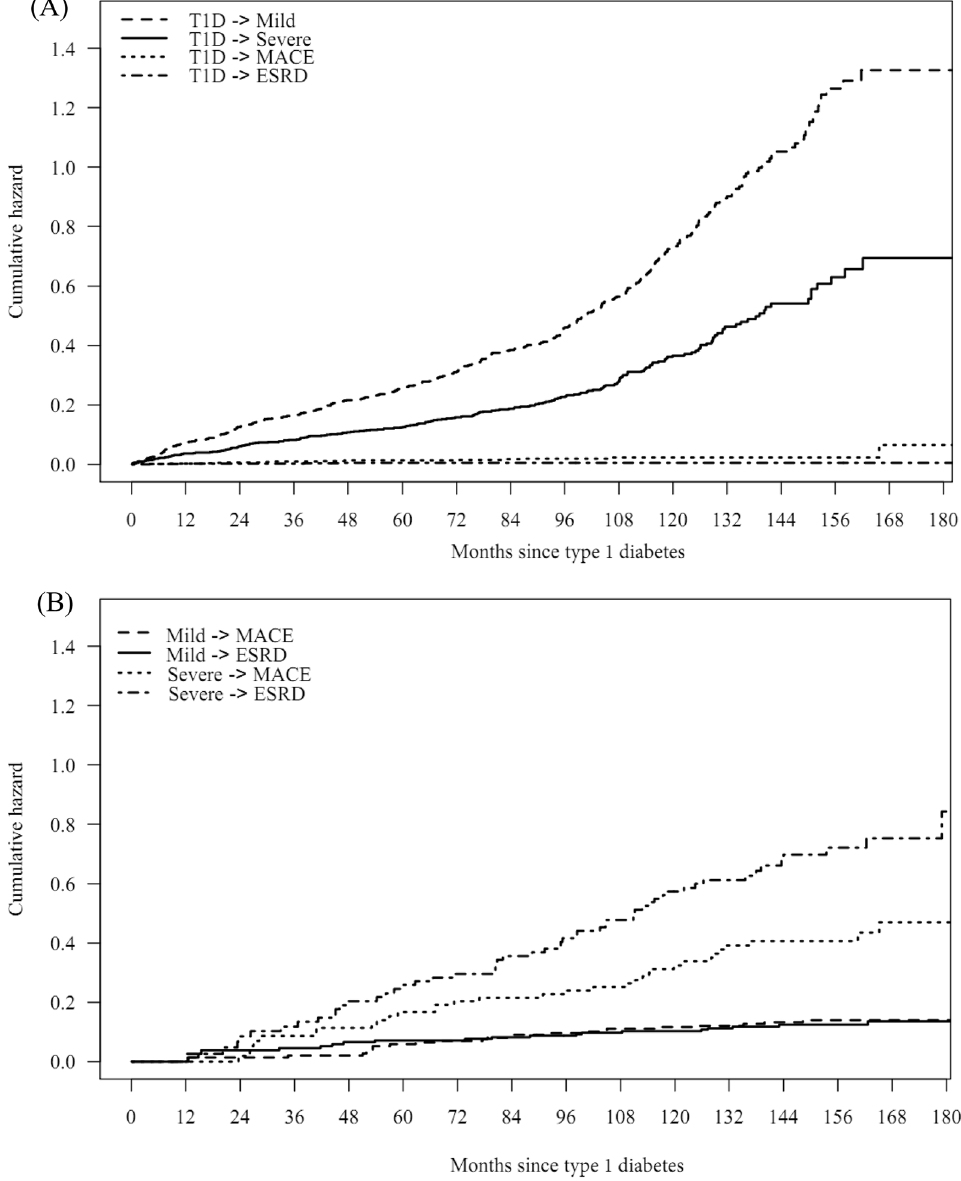
transition from mild DR or severe DR to ESRD or